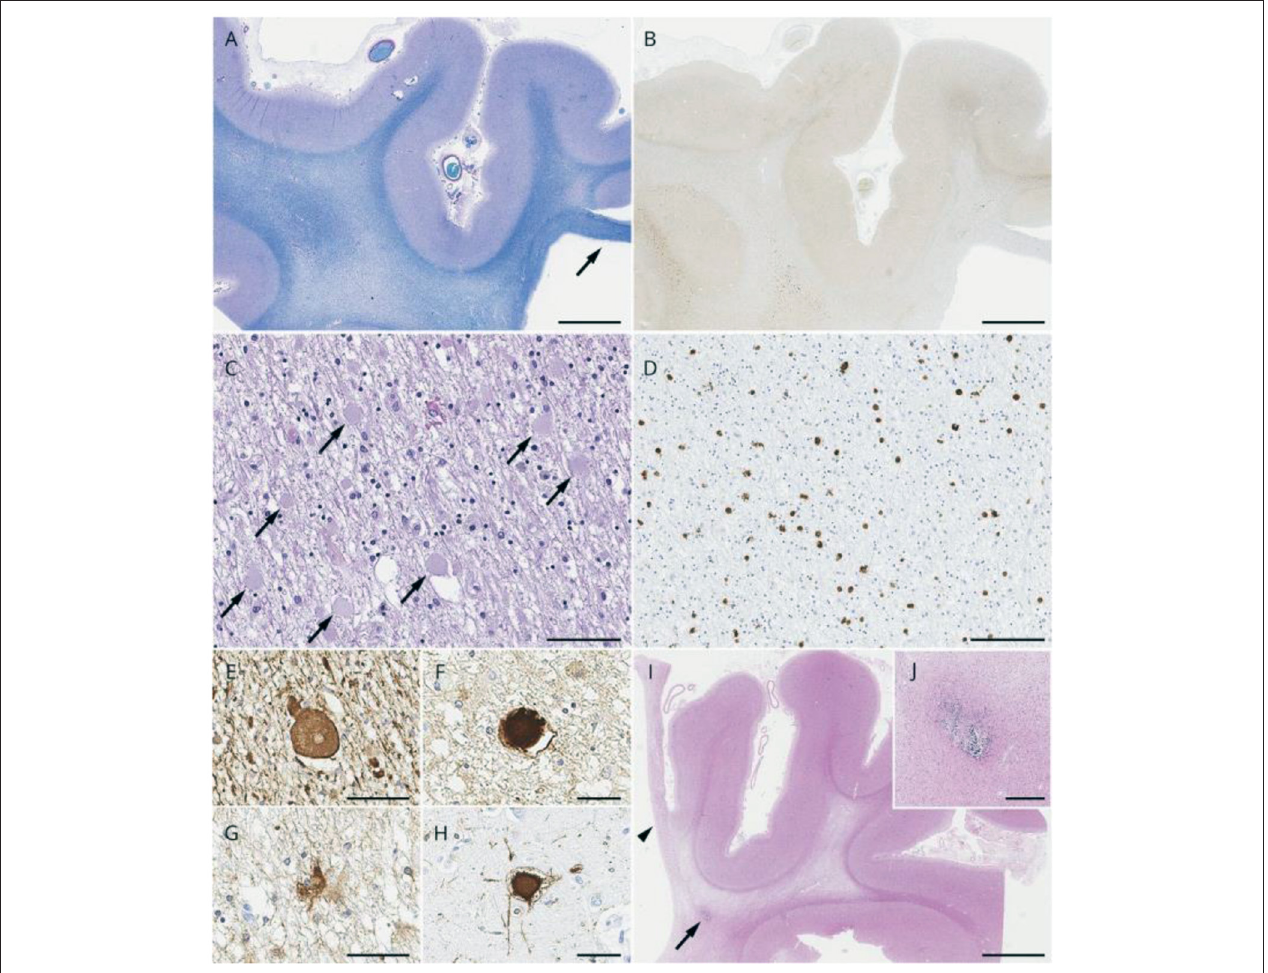
FIGURE 2 | Pathologic light microscopic findings from cases with Colony-Stimulating Factor 1 receptor ( CSF1R )-related leukoencephalopathy. (A–H) A 78-year-old man with CSF1R p.M875T. At 71 years of age, he developed cognitive impairment followed by personality and behavior change, depression, executive dysfunction, apraxia, parkinsonism, and pyramidal weakness. He died after 7 years of disease duration. (A) Luxol fast blue stain shows severe myelinated fiber loss in the superior frontal and cingulate white matter, whereas the U-fibers are relatively spared. Note the thinning of the corpus callosum (arrow). (B) The axonal spheroids in the affected white matter are stained with amyloid precursor protein (APP). (C) Numerous axonal spheroids (arrows) are seen within the frontal white matter (hematoxylin and eosin). (D) 68-immunopositive macrophages in the frontal white matter. (E,F) An axonal spheroid in the white matter depicted by phosphorylated neurofilament (SMI31) (E) and APP (F) . (G) A bizarre astrocyte in the white matter ( α B-crystallin). (H) A ballooned neuron in the superior frontal cortex ( α B-crystallin). (I,J) A 55-year-old woman with autopsy-confirmed adult-onset leukodystrophy with neuroaxonal spheroids and pigmented glia, but genetic testing was not performed because DNA was unavailable. (I) Note the small, calcified lesion (arrow) located in the pericallosal region. An arrowhead indicates the paper-like atrophy of the corpus callosum. (J) An enlarged image of the calcification. Bars in A, B, and I = 5mm; C and D = 100 µ m; E, F, G, and H = 50 µ m; and J = 400 µ m. Reprinted with permission from